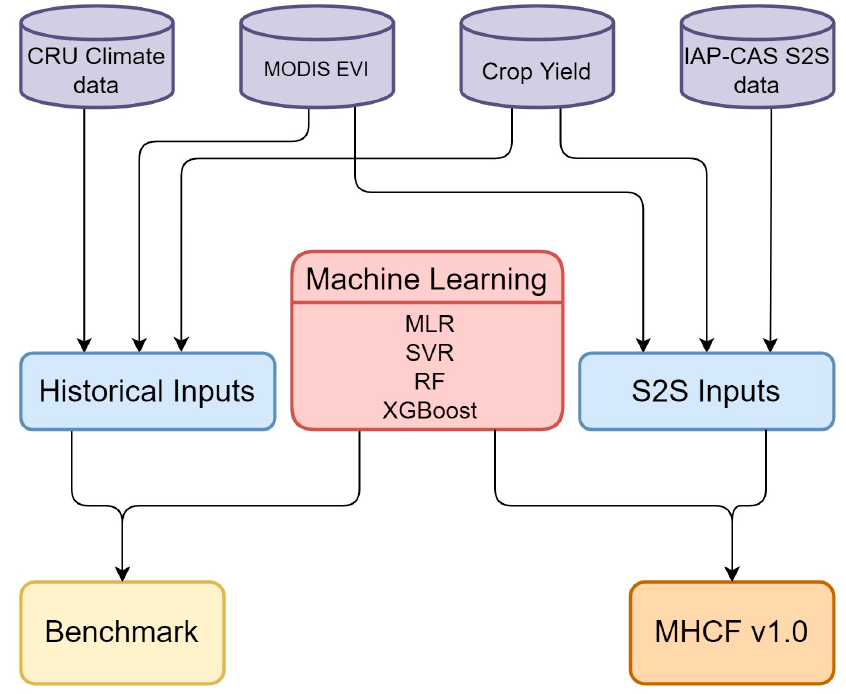
Figure 2. A flow diagram of the yield modeling steps in this study.